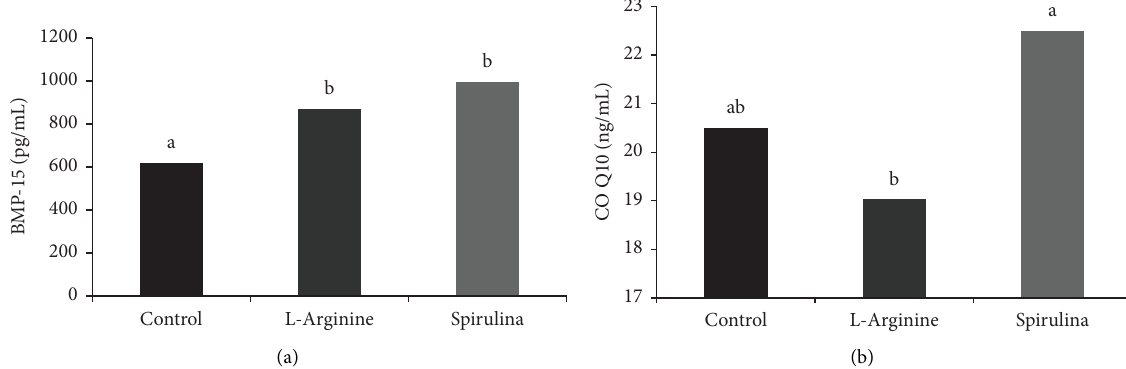
Figure 2: Efect of oral administration of Spirulina or L-arginine to sheep ewes induced for twinning on plasma BMP-15 (a) and CO Q10 (b). ( a , b P < 0 .